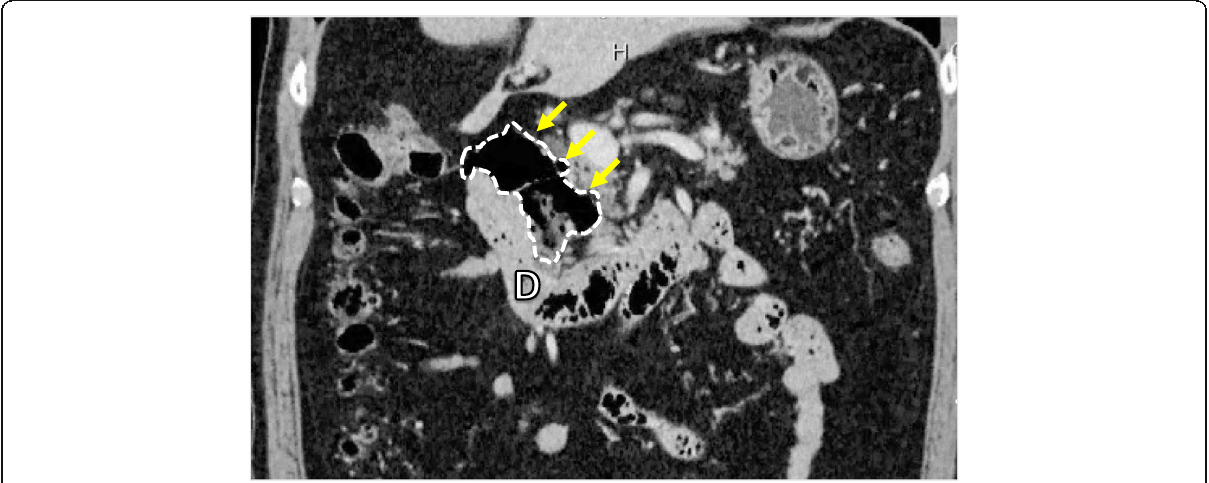
Fig. 1 Computed tomography of case 1 before gastrectomy. A large periampullary diverticulum (yellow arrow) situated at the second part of the